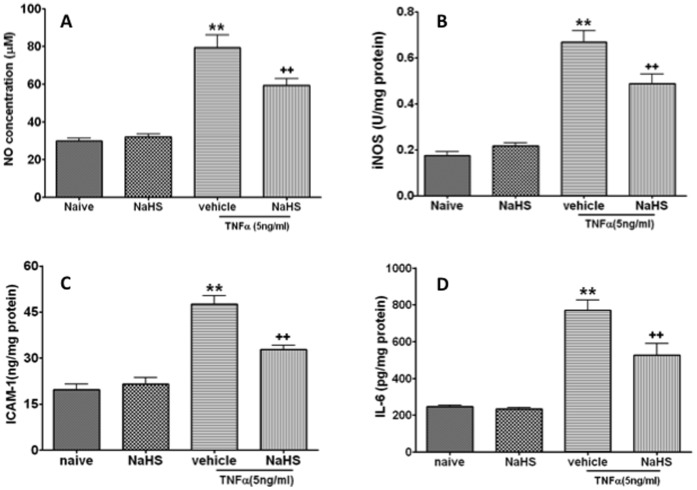
NaHS suppresses the productions of oxidative and inflammatory mediators in pulmonary micro-vessel endothelial cells induced by TNF-α.Nitric oxide concentration (A), Inductive nitric oxide synthase (B), Intercellular adhesion molecule (ICAM) 1 (C) and interleukin (IL) 6 (D). Data are mean ± SEM (n = 12); ** p<0.01 vs Naïve,++p<0.01 vs vehicle.